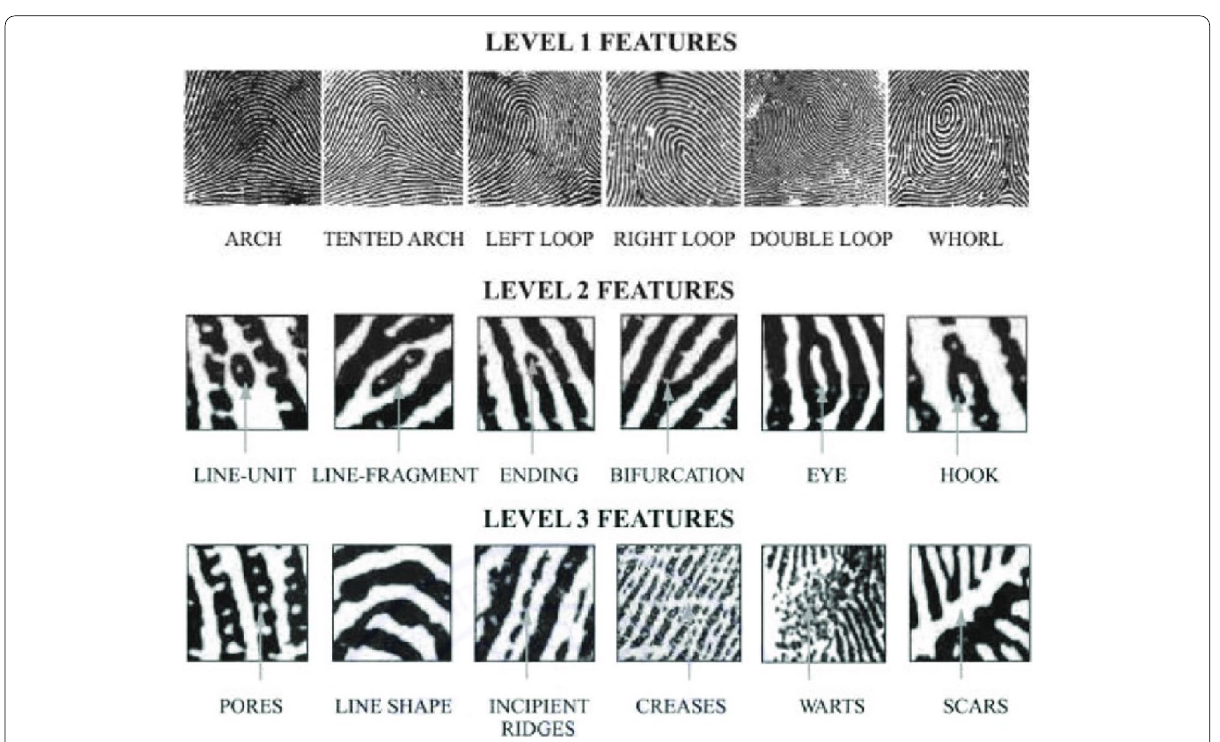
Fig. 1 Different levels of features in a latent fingerprint (Krishna & Sudha,